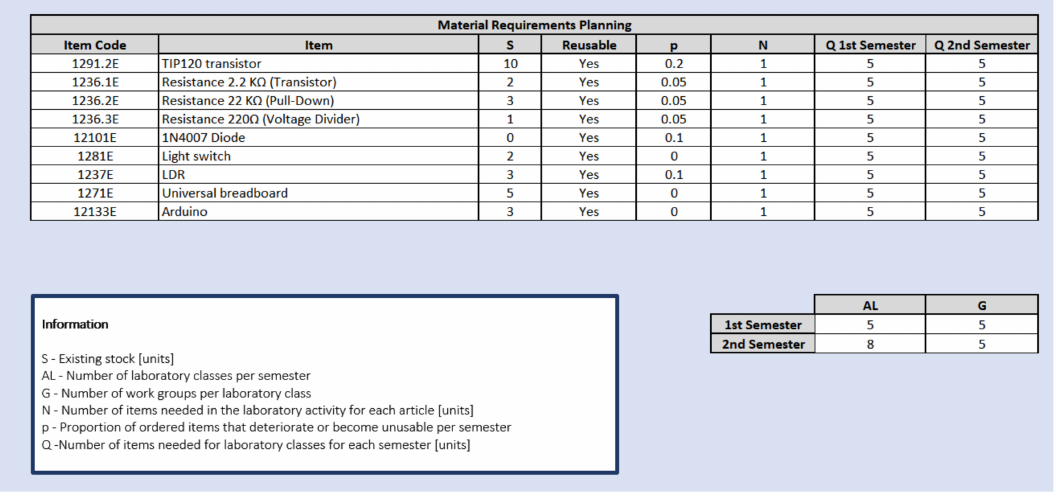
Figure 6. “Semester Planning”